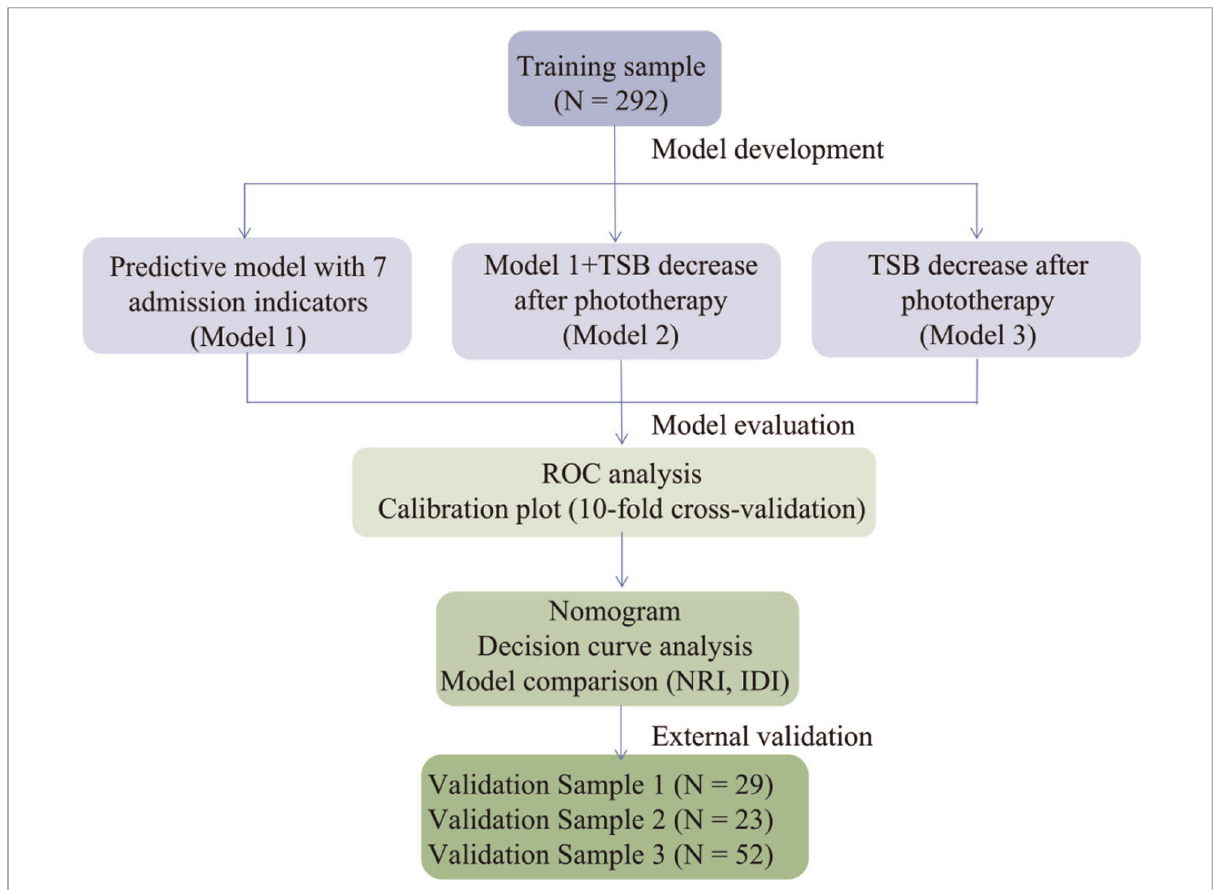
FIGURE 1 Work fl ow of predictive model development and validation. TSB, total serum bilirubin; ROC, receiver operator characteristics; NRI, net reclassi fi cation improvement; IDI, integrated discrimination